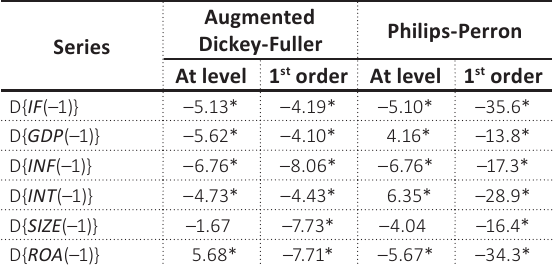
Table 3. The results of unit root